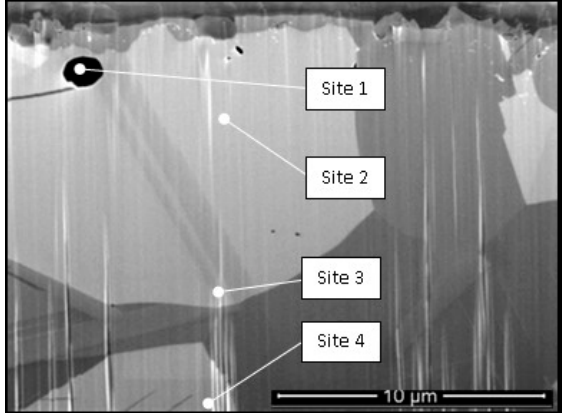
Figure 18. Cross-section SEM image of Inconel 625 sample after 2500 h heating (10,000×).